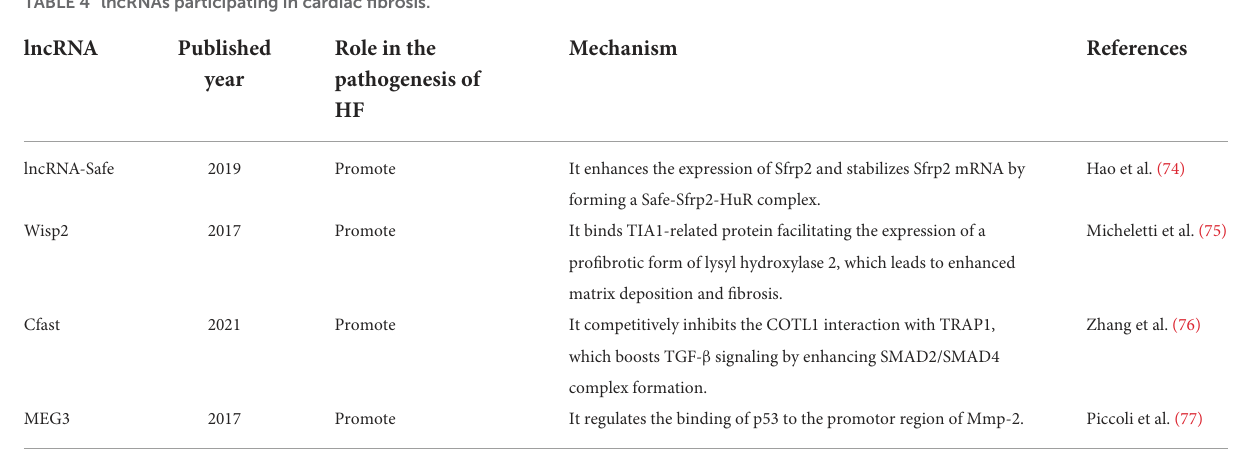
TABLE 4 lncRNAs participating in cardiac